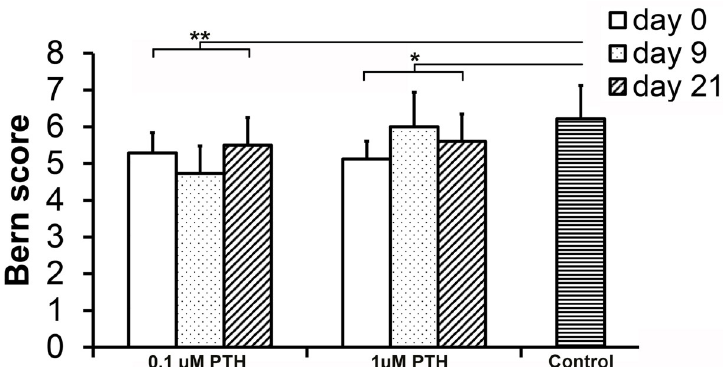
Fig 2. Bern score of human chondrocytes cultured for 28 days in the presence of 0.1 or 1.0 μ M PTH from day 0, 9 or 21 onwards. Controls did not receive PTH. 0.1 μ M and 1 μ M PTH addition resulted in lower Bern scores compared with controls ( � : p = 0.006, �� : p = 0.022, respectively). No differences were observed between PTH concentrations or moment of supplementation. Graphs show mean ± 95% C-I. n = 6.